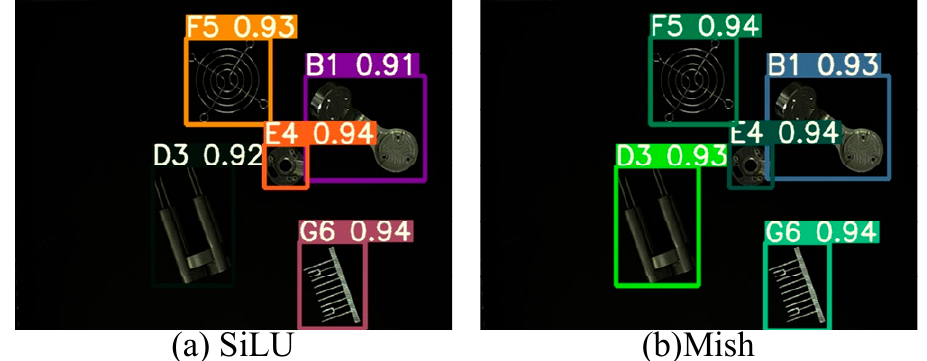
Figure 15. Results of NP-YOLOv5.